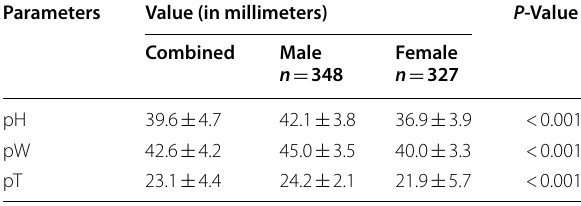
Values are presented as mean SD, *Significance was set at 0.05 as tested by ± student t -test for two independent